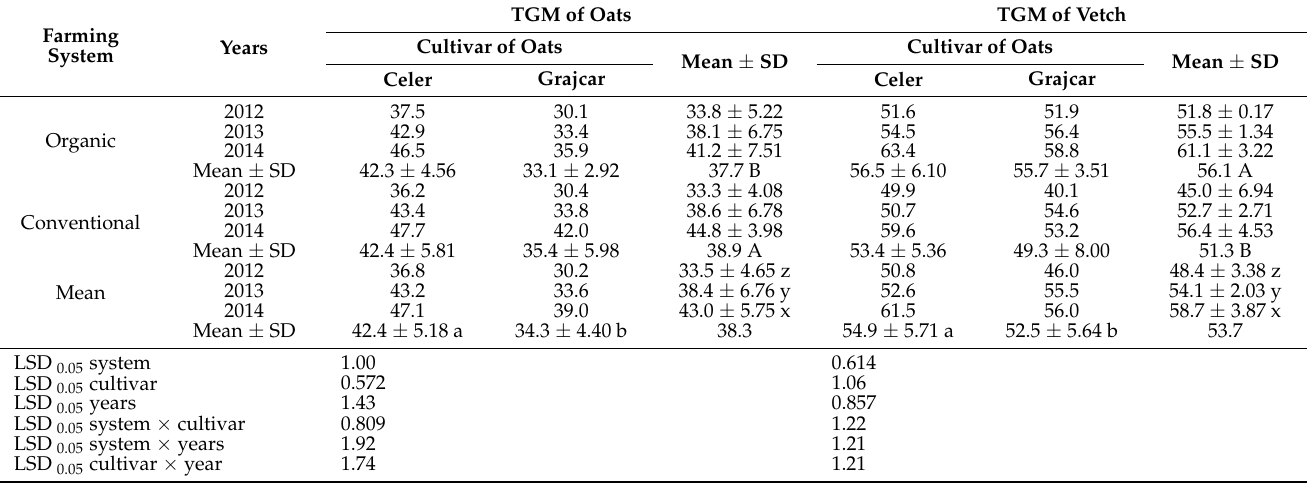
Table 9. The thousand-grain mass (TGM) of oats and vetch (g) in the oat-vetch mixture, depending on the farming system and oat cultivar in